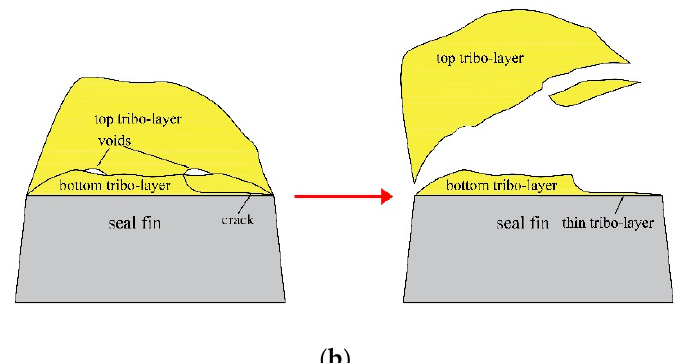
Figure 16. ( a ) The thickening of the tribo-layer; ( b ) the formation of the thin tribo-layer. Accompanied by periodical formation and spalling of the tribo-layer, small peaks on